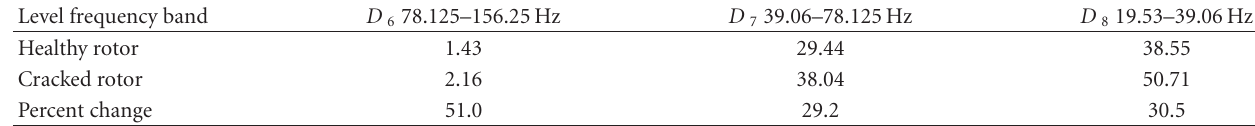
Table 2: Comparison of rms values ( μ m) of healthy and cracked rotors with no excitation.